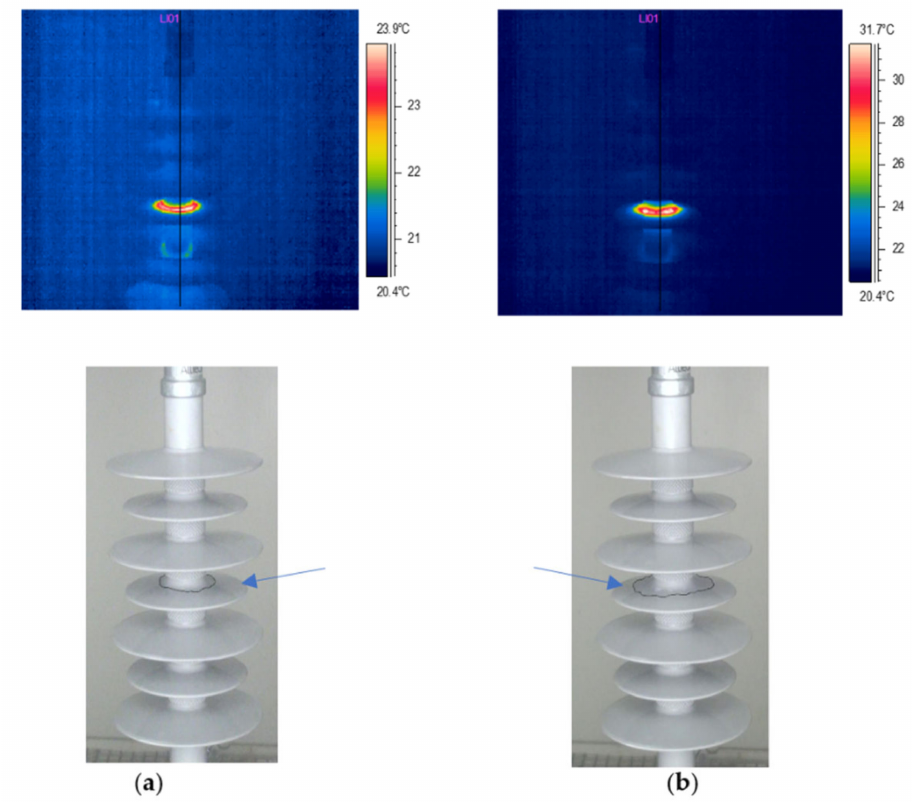
Figure 10. Dry-band formation and extension for medium pollution. ( a , b ) represent DB extension.